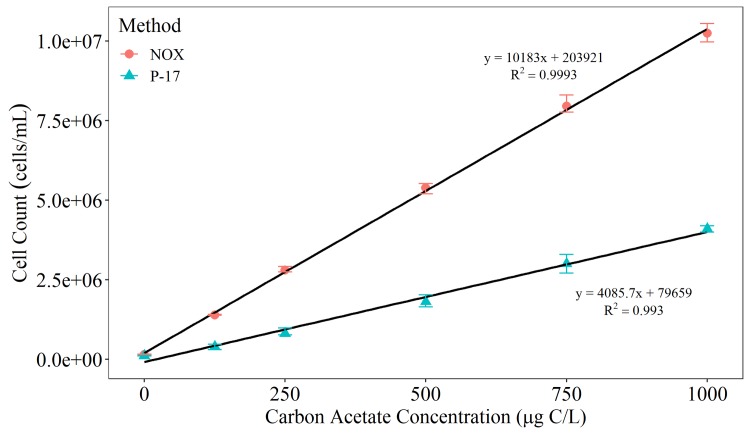
Yield factors produced when using NOX and P-17 grown in 0 – 1000 μg/L sodium acetate solutions.Samples were inoculated with 10,000 cells ml-1, incubated at 15°C until maximum cell growth was achieved and enumerated using flow cytometry. Total cell counts are presented as averages ± standard deviation. The average (n = 3) cell counts (± standard deviation) are plotted.